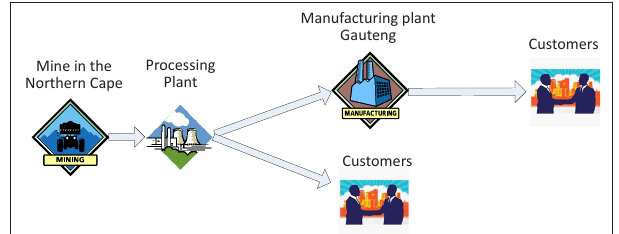
FIGURE 1: The distinct supply chains of Firm